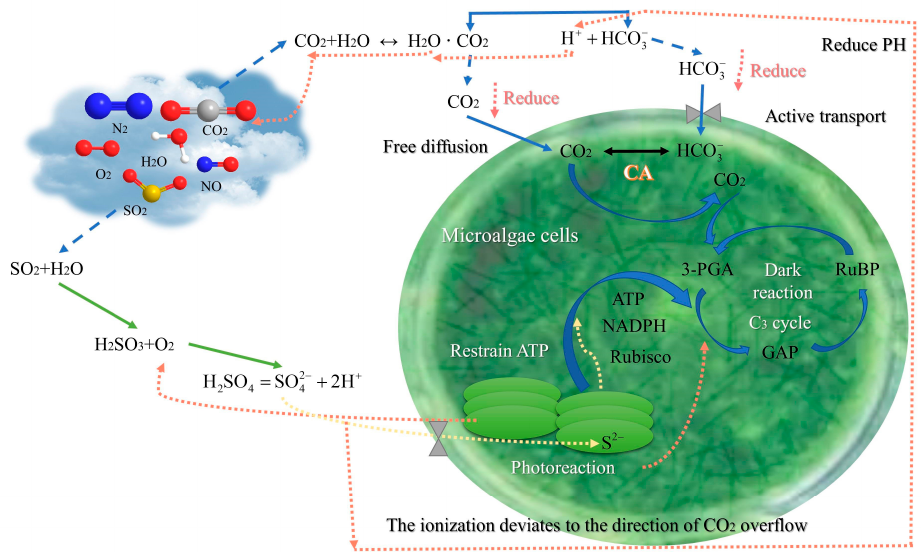
Figure 7. Mechanism of the inhibition of microalgae CO 2 fixation by SO X.